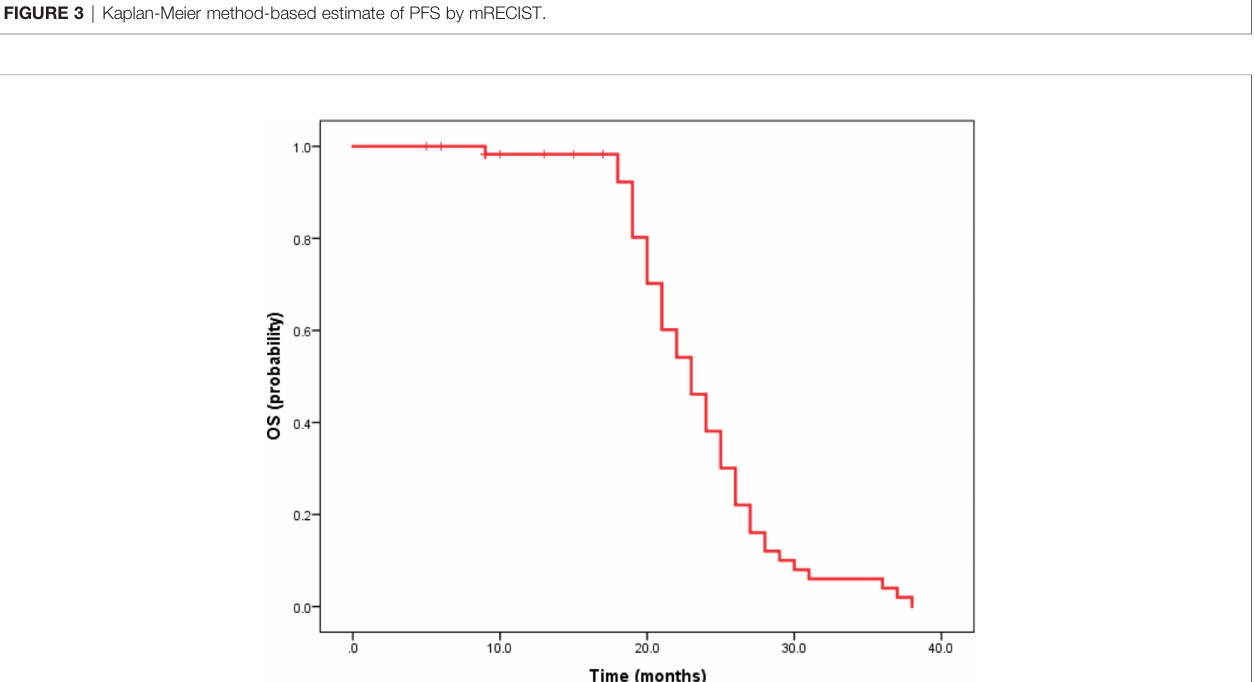
FIGURE 4 | Kaplan-Meier method-based estimate of OS by mRECIST. Imaging data of a 63-year-old male patient.